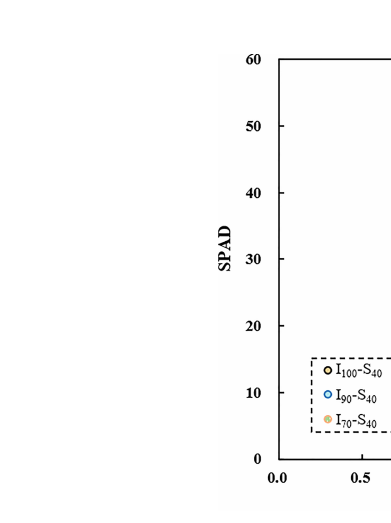
FIGURE 5 The relationship between SPAD and WUE ET as in fl uenced by different water regimes and soil clay contents. ** represents p